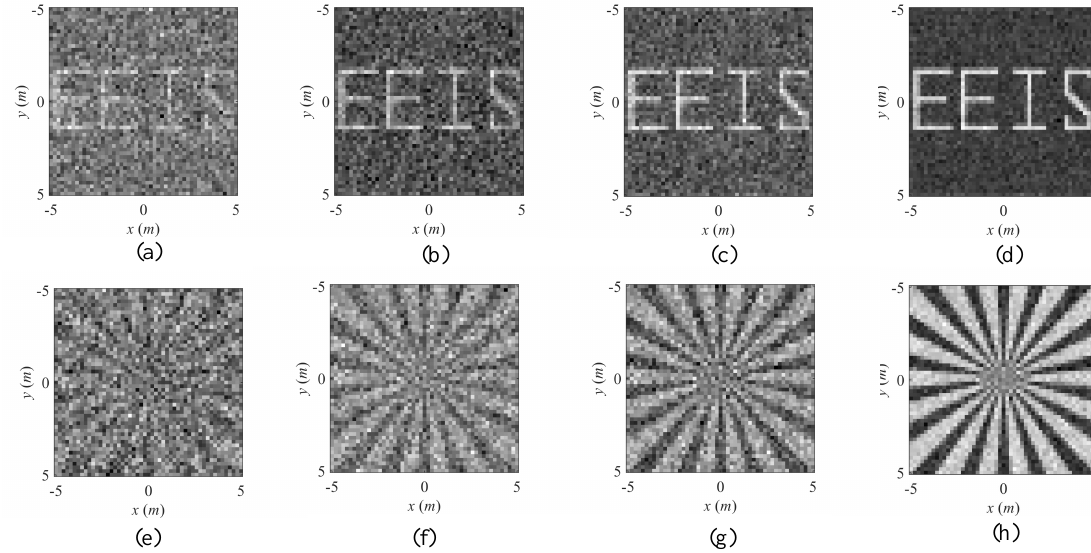
Figure 8. Imaging results of TD-MSCI with unused frequency combinations. ( a – d ) are recovery results of target 1 with the amount of added TSSRF equal 1000, 5000, 10,000, 50,000. ( e – h ) are recovery results